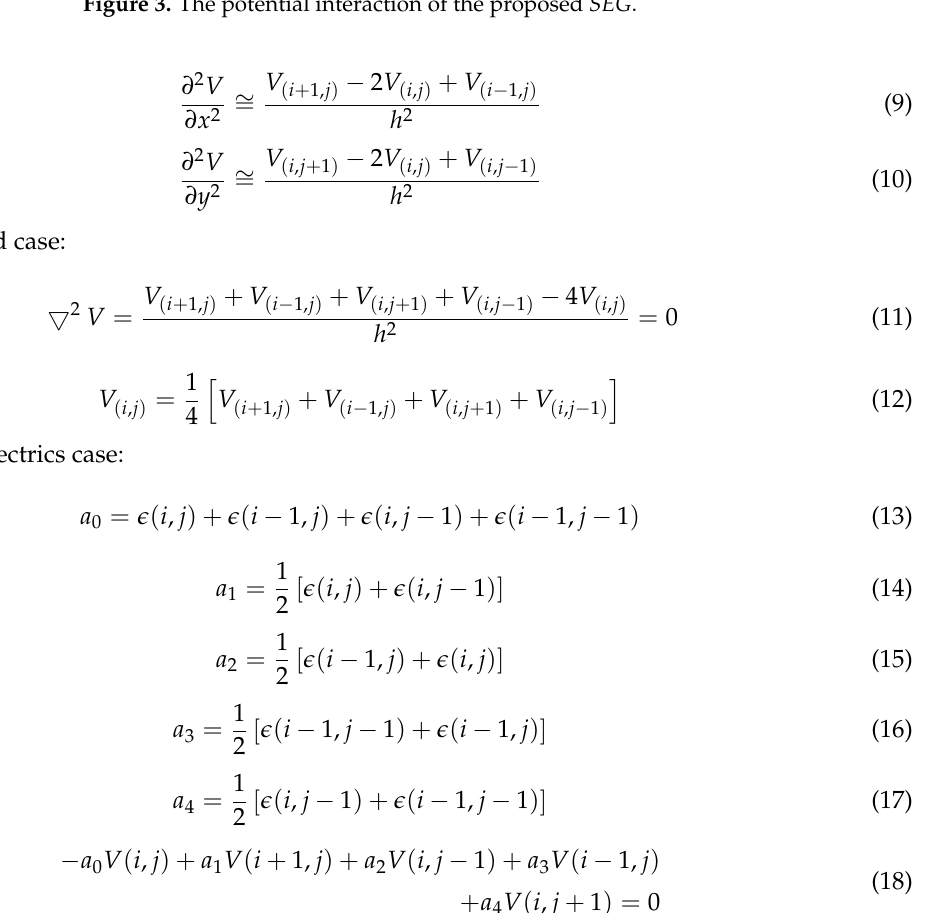
Figure 3. The potential interaction of the proposed SEG